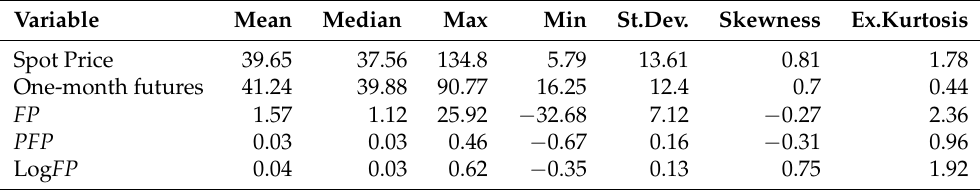
Table 1. Descriptive statistics for the spot price, futures price and forward